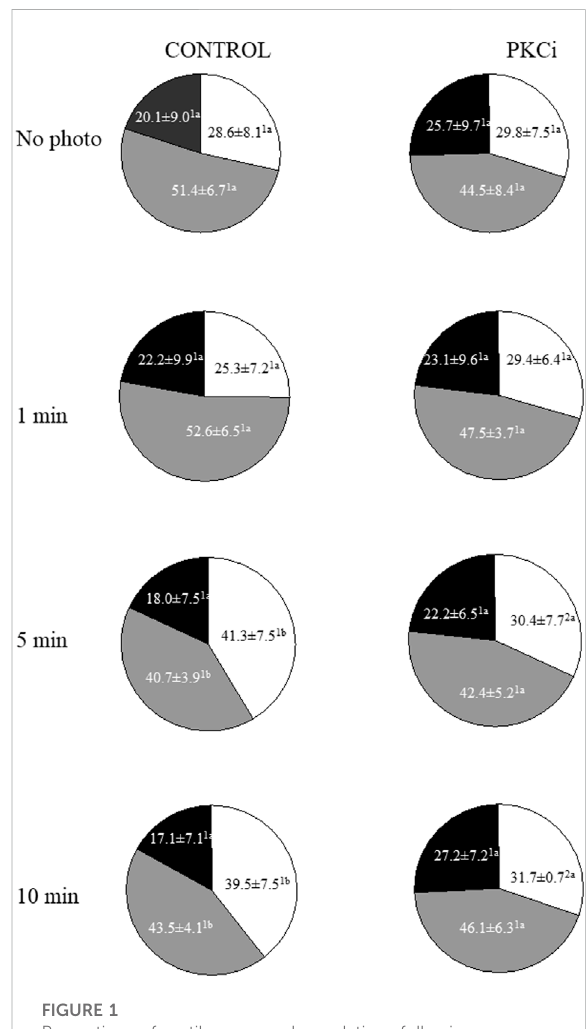
FIGURE 1 Proportions of motile sperm subpopulations following incubation with or without PKCi and further irradiation of sperm with red LED light. Sperm were not irradiated (No Photo) or irradiatedfor1 min(1 min),5 min(5 min)or10 min(10 min)in theabsence(CONTROL)orpresenceof100 nMPKCi(PKCi).White sections: percentages of sperm included in Subpopulation 1. Grey sections:percentagesofspermincludedinSubpopulation2.Black sections: percentagesof sperm included in Subpopulation 3. Total numberofanalyzedspermwas10,237.Differentsuperscriptletters indicate signi fi cant ( p < 0.05) differences between samples that werelight-irradiatedwithdifferentpatterns(i.e.,1,5or10 min)and those that were not irradiated (i.e., 0 min), regardless of whether they were previously incubated with PKCi. Different superscript numbers indicate signi fi cant ( p < 0.05) differences between samples incubated with PKCi and those non-incubated with the inhibitor, and irradiated with the same pattern (i.e., 1, 5 or 10 min). Eight biological replicates involving eight independent samples were